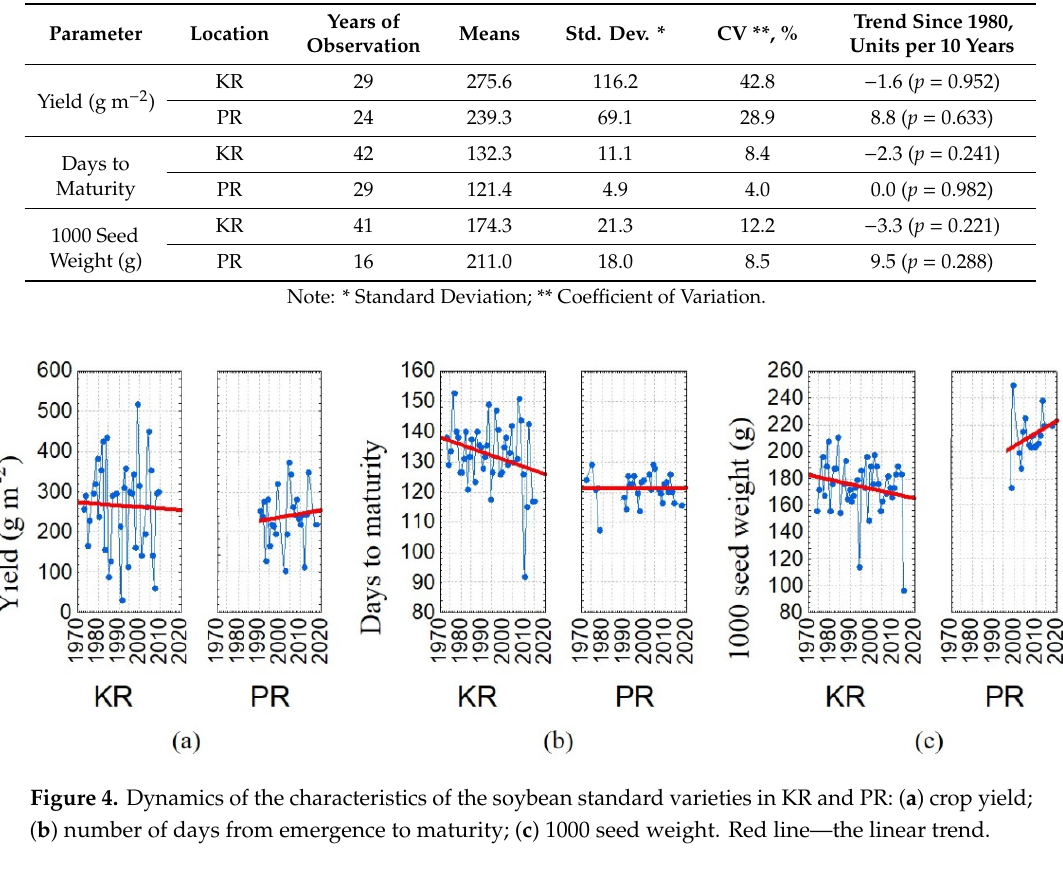
Note: * Standard Deviation; ** Coefficient of Variation.